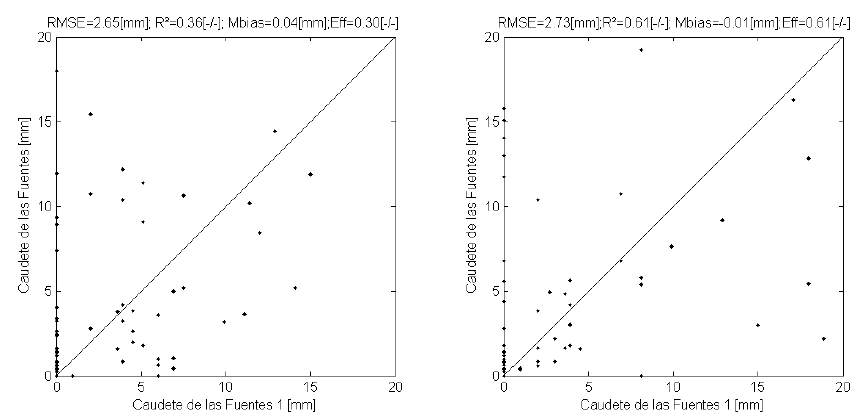
Fig. 5. Precipitation events at Caudete de las Fuentes ( y -axis) versus Caudete de las Fuentes 1 ( x -axis) rain gauges for 2006 (left hand figure) and 2007 (right hand figure). See Fig. 3 for gauge positions.